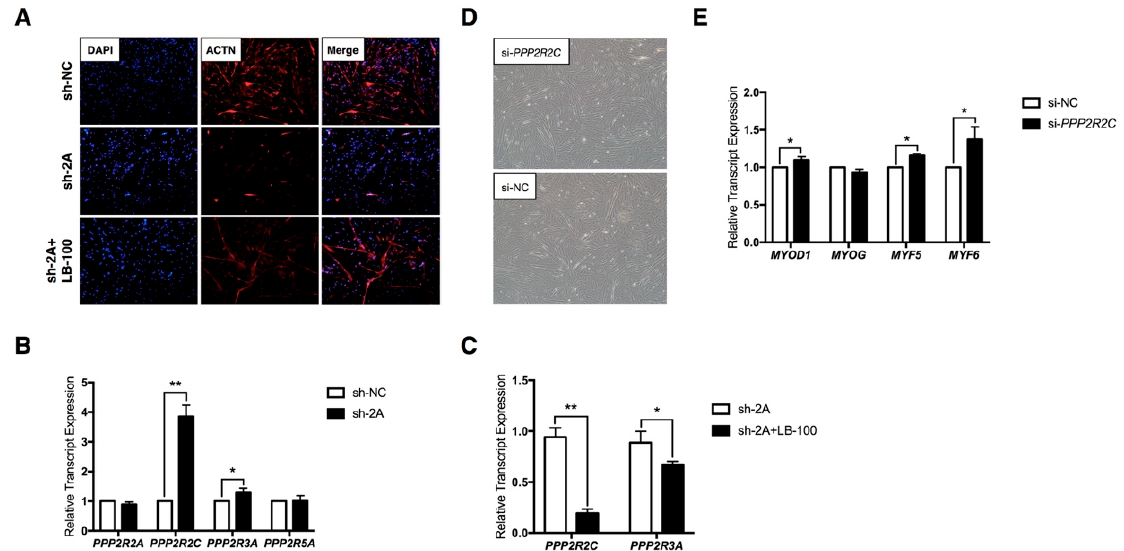
Figure 3. MEF2A regulates PP2A signaling during myoblast differentiation. ( A ) Inhibition of MEF2A repressed myoblast differentiation, while the addition of LB-100 rescued the disrupted myotube formation (magnification: 100×); ( B ) Real time PCR (RT-PCR) analysis of PPP2R2A , PPP2R2C , PPP2R3A , and PPP2R5A in MEF2A-inhibited myocytes; ( C ) RT-PCR analysis of